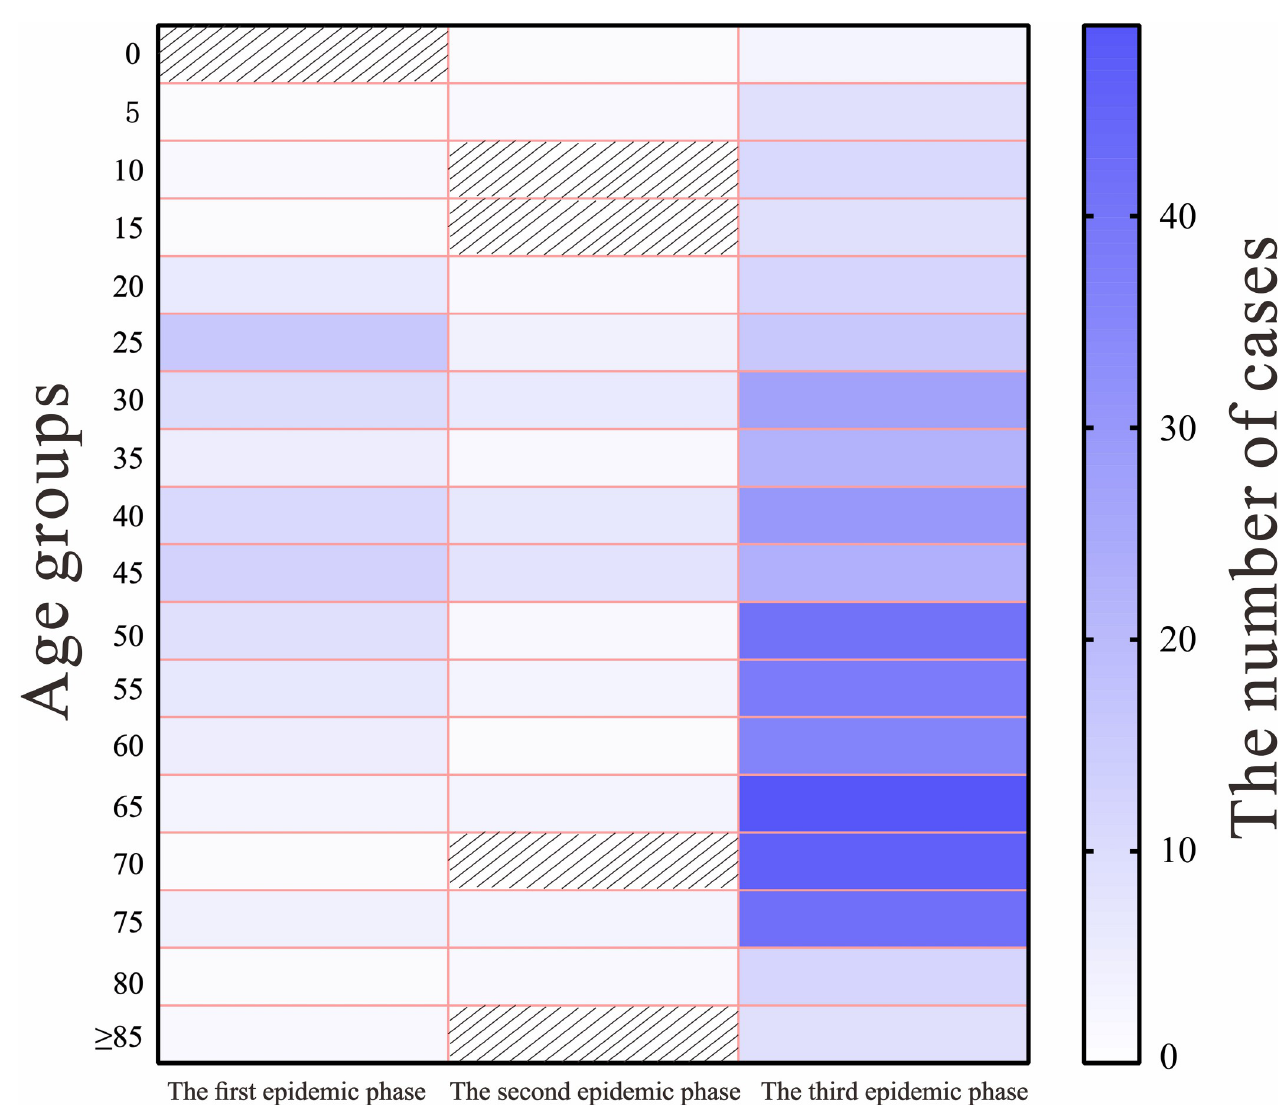
Fig 2. Age distribution of the three phases of the COVID-19 outbreaks in Jilin Province.